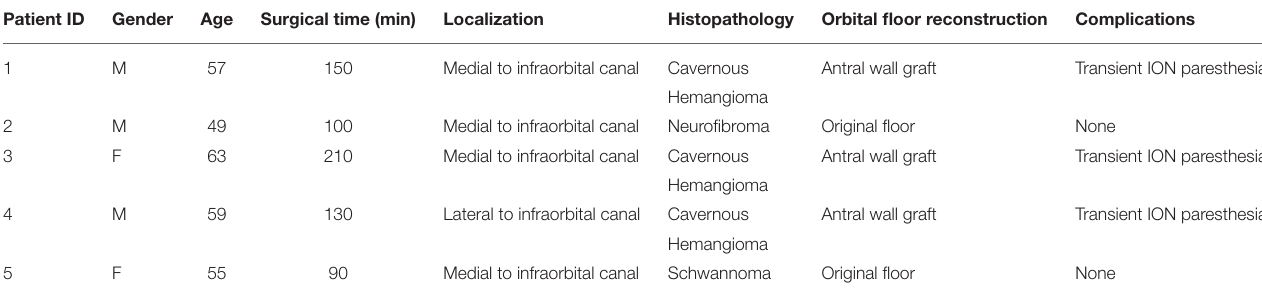
TABLE 1 | Demographic and surgical characteristics of patients enrolled in this study.